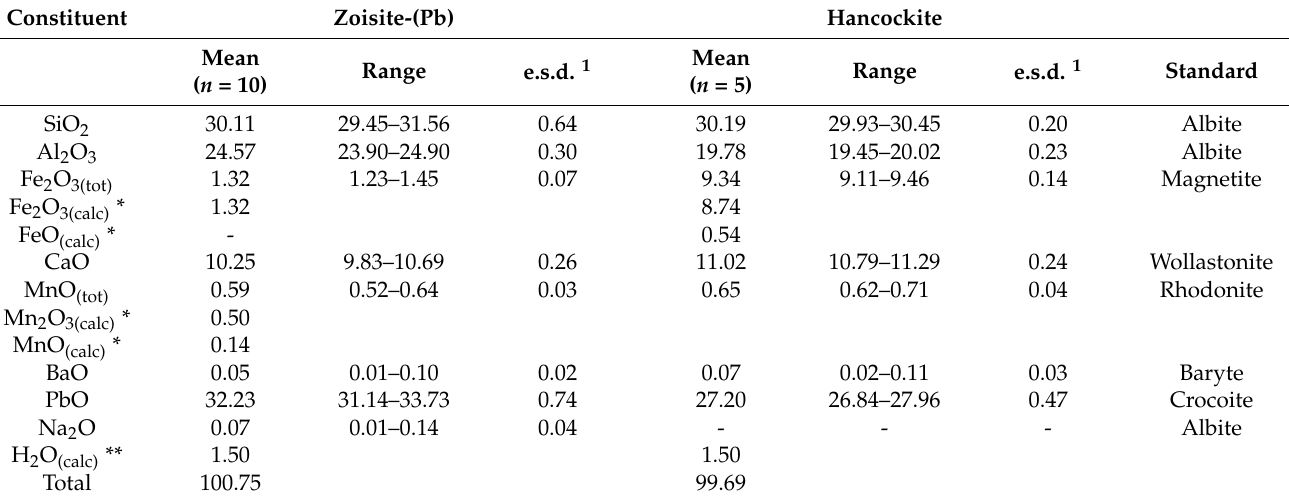
Table 1. Chemical composition (in wt%) of zoisite-(Pb) and